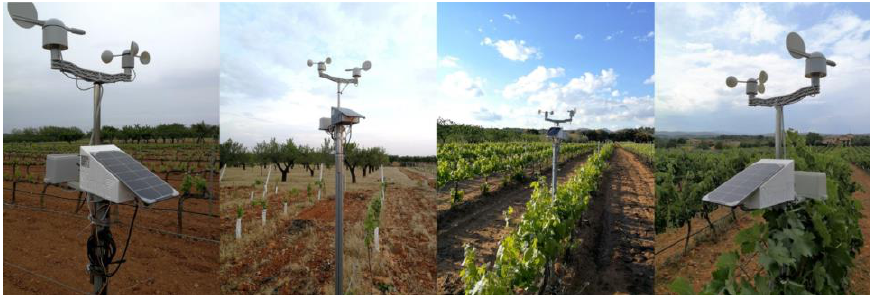
Figure 11. Weather stations to monitor the vineyard meteorological data (reproduced from [79] with permission from Sensors , 2020).